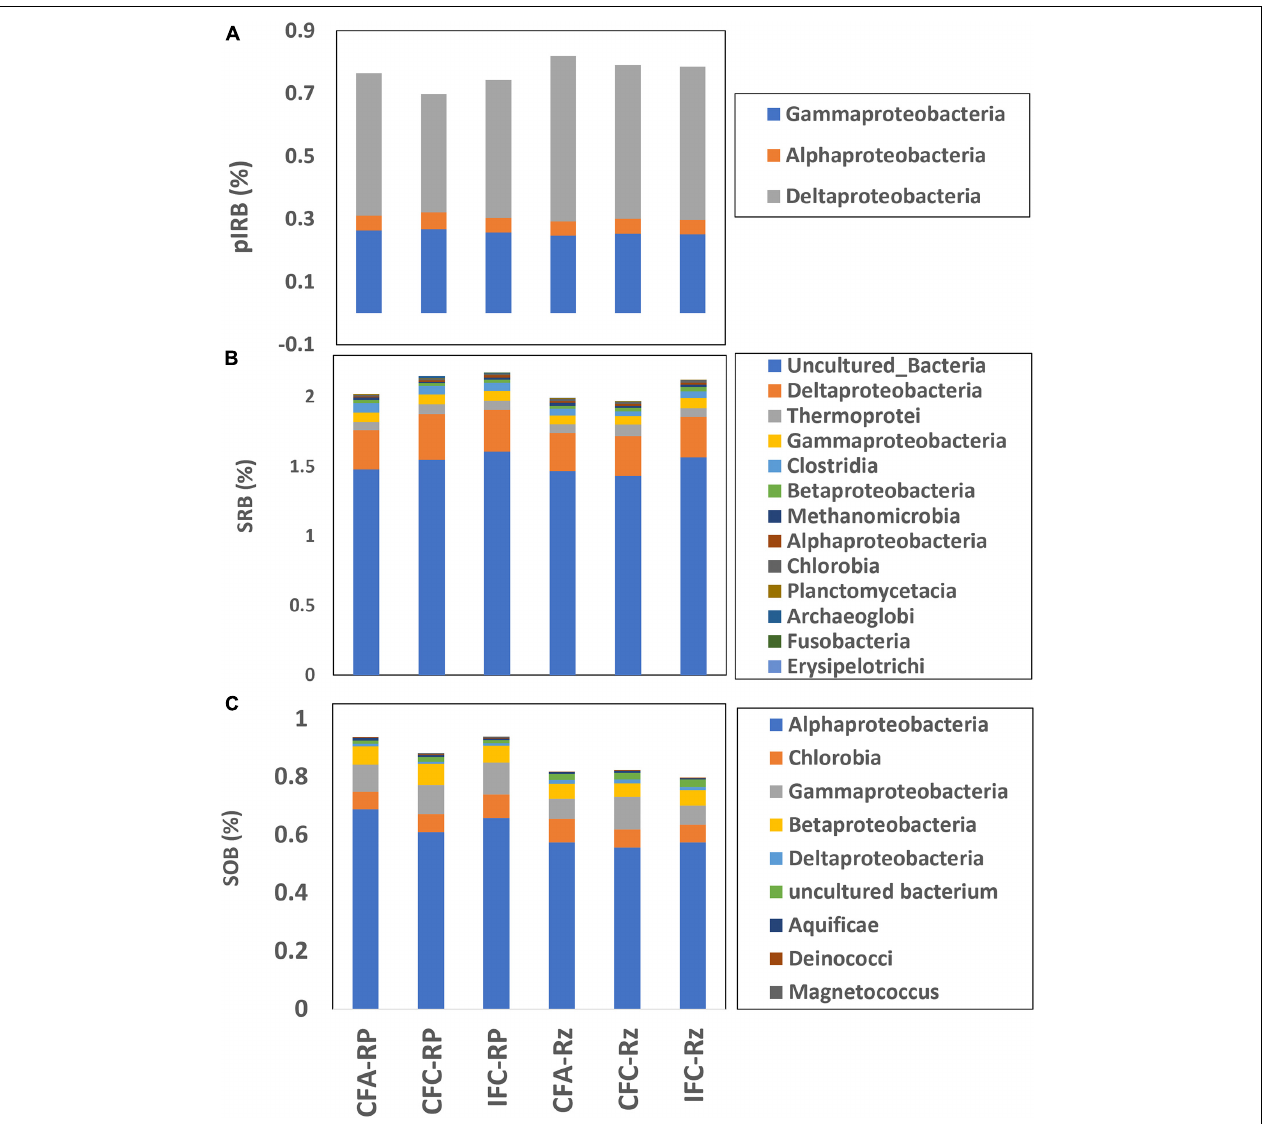
FIGURE 4 | Relative abundance of major taxonomic classes represented within (A) cytochrome gene probes, (B) SRB (dsrA/B, APS_AprA/B gene probes), and (C) SOB (SOX gene probes) in the rhizosphere compartments under different soil As and water management treatments. CFA, continuously flooded-arsenic; CFC, continuously flooded-control; IFC, intermittently flooded control. Suffix RP and Rz in group labels represent the root-plaque and the rhizosphere samples, respectively.